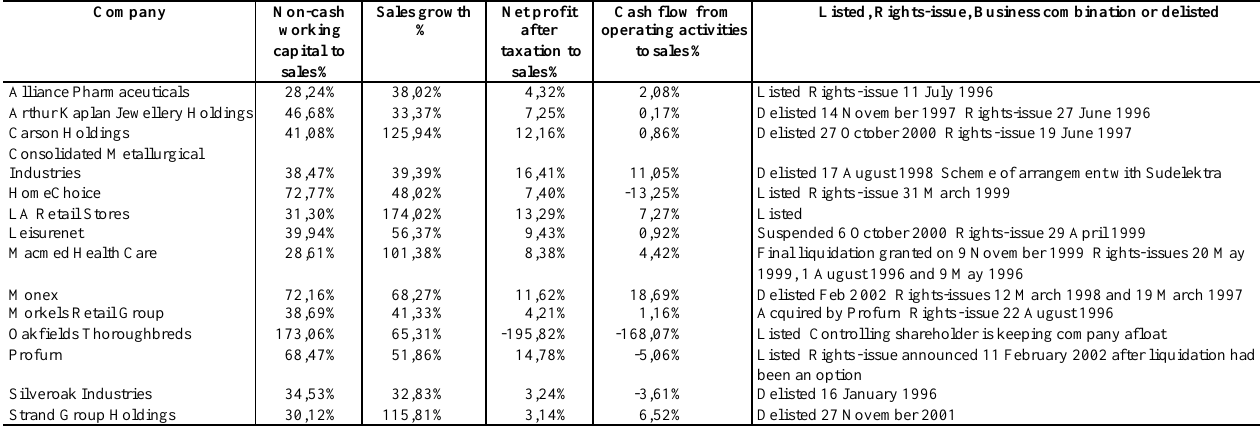
Table 4: Companies in the top quintile of high growth as well as non-cash working capital on average for a four-year